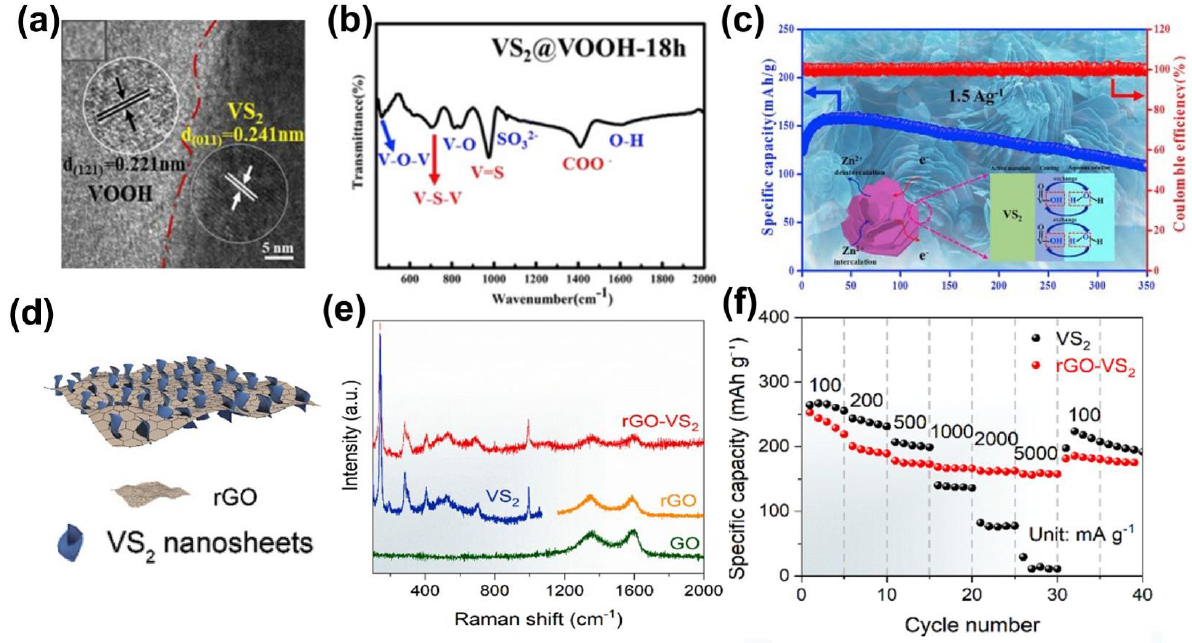
Figure 7. Hybridization of TMDs for high − performance ZIBs. ( a ) HRTEM images of the VS 2 @VOOH. ( b ) FTIR spectra of VS 2 @VOOH. ( c ) Cycling retention at 1.5 A·g − 1 of VS 2 @VOOH. Reprinted with permission from Ref. [51] . Copyright 2019, Elsevier. ( d ) Illustration of hierarchical rGO − VS 2 compo- sites. ( e ) Raman characterization of the GO, rGO, VS 2 , and rGO − VS 2 . ( f ) Rate capability of rGO − VS 2 and VS 2 Reprinted with permission from Ref. [54]. Copyright 2020, Elsevier.